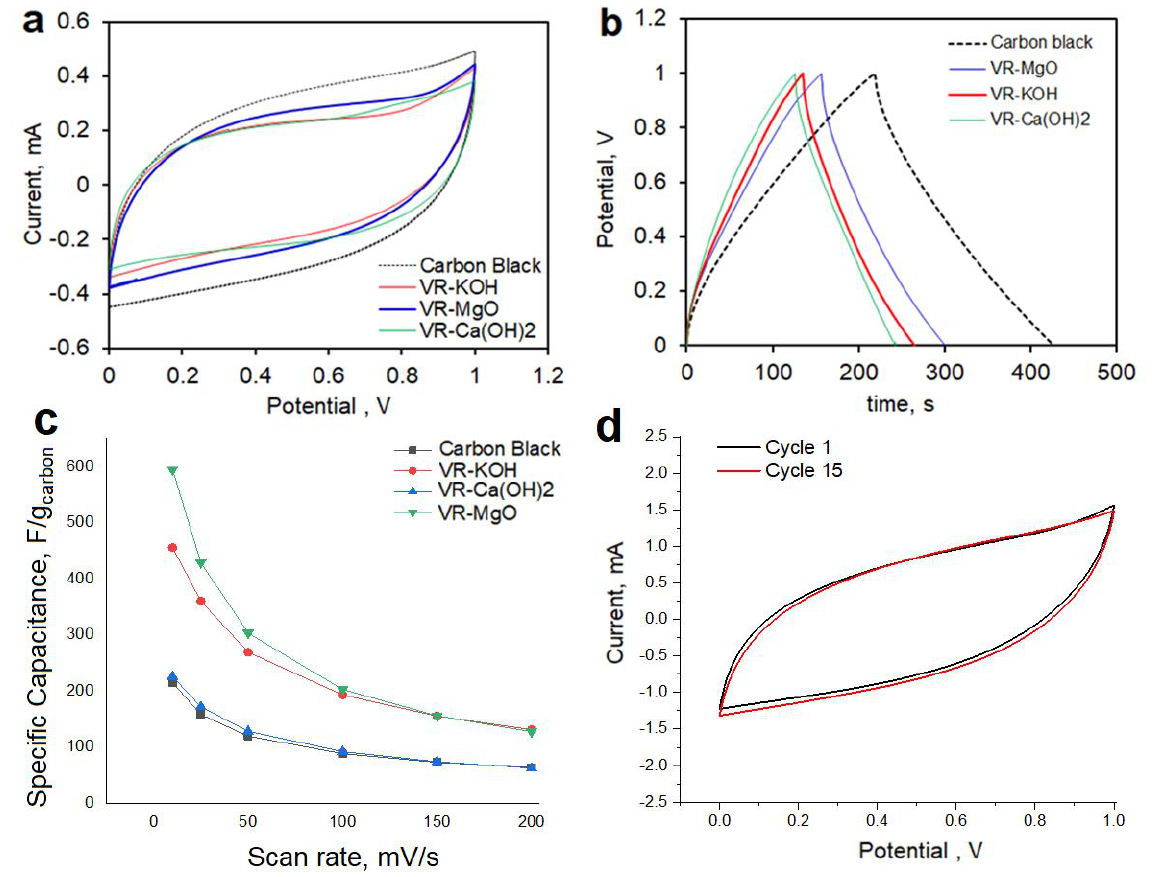
Figure 6. ( a ) Cyclic voltammetry of carbon black, VR-KOH, VR-Ca(OH) 2 , and VR-MgO at 10 mV/s scan rate; ( b ) charge–discharge curves at a current density of 0.200 mA in 1 M KNO 3 electrolyte; ( c ) variation of specific capacitance with a scan rate of carbon electrode performed in 2-electrode cell configurations in 1 M KNO 3 electrolyte; and ( d ) cyclability of VR-KOH electrode in 1 M KNO 3 electrolyte.